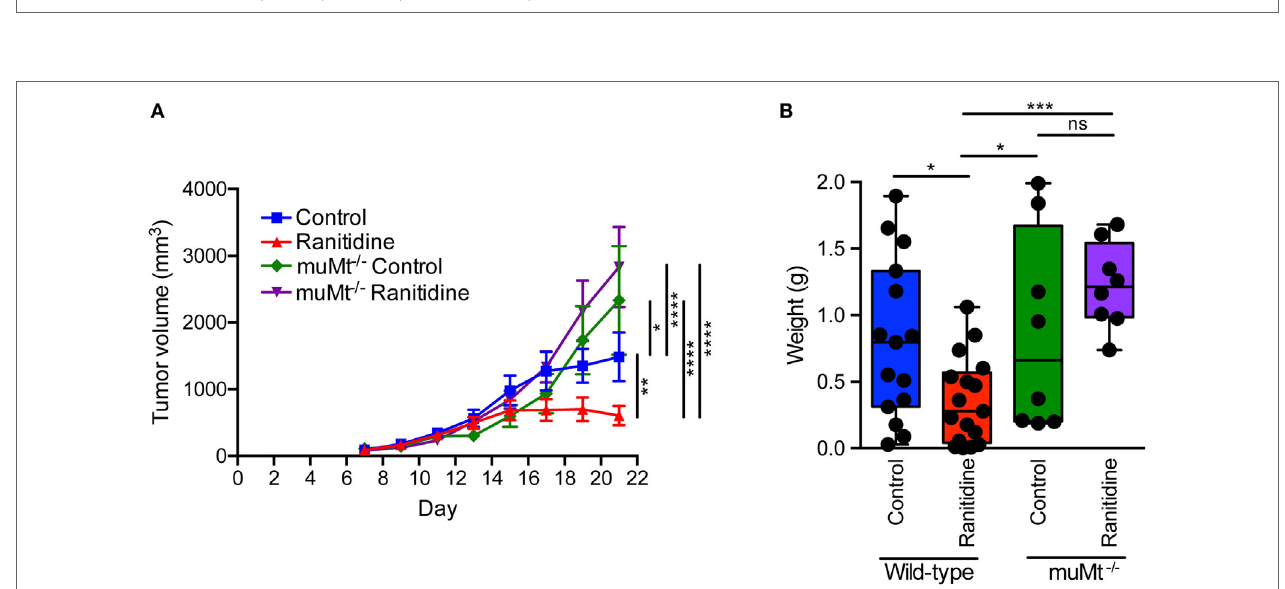
FigUre 5 | Ranitidine does not impact E0771-GFP tumor growth in B cell-deficient C57BL/6 mice. (a,B) E0771-GFP tumors in muMt − / − and wild-type C57BL/6 mice treated with ranitidine (8 mg/kg) were measured every 2 days starting 7 days post E0771-GFP cell injection. (a) At day 21, the primary tumor was excised and weighed (B) . Data in panel (a) represents the mean ± SEM tumor volume of 8–17 mice/point, significance was assessed using two-way ANOVA with uncorrected Fisher’s LSD multiple comparisons. Data points in panel (B) represent final tumor weight of individual mice, significance was assessed using two-way ANOVA with uncorrected Fisher’s LSD multiple comparisons. * p < 0.05, ** p < 0.01, *** p < 0.001, **** p < 0.0001, NS, not significant.